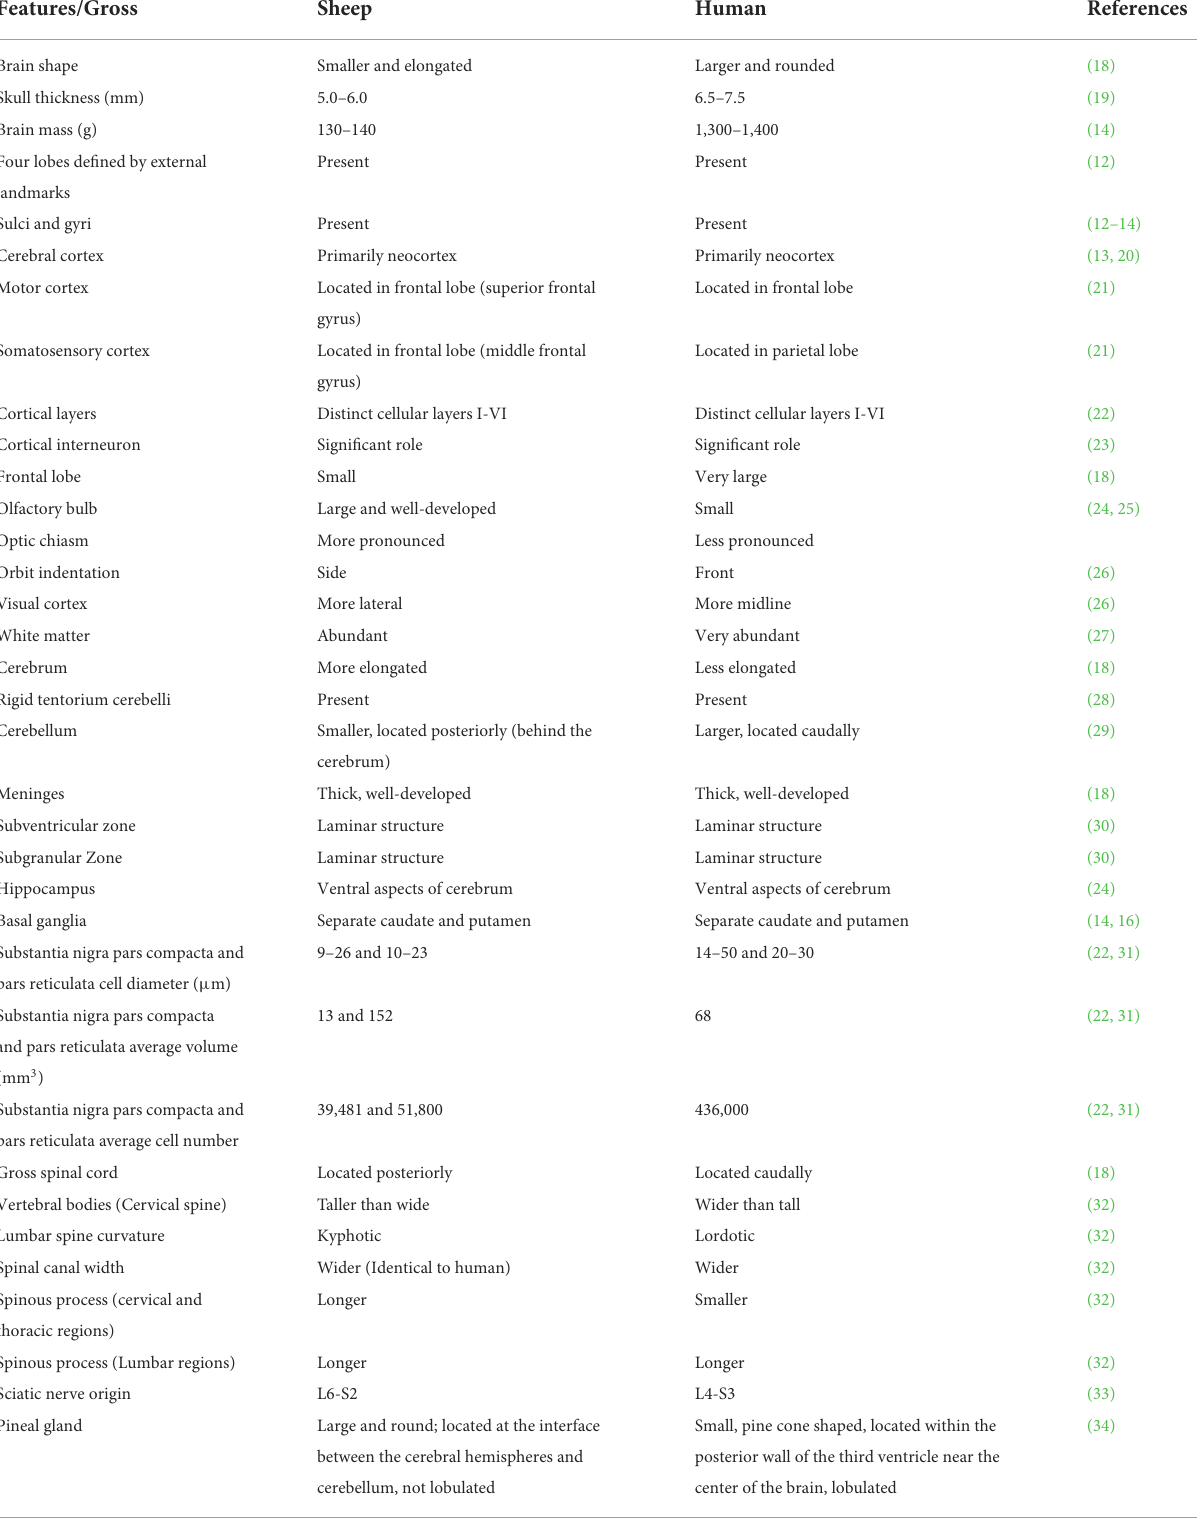
TABLE 1 Comparisons of the central nervous system between sheep and humans.